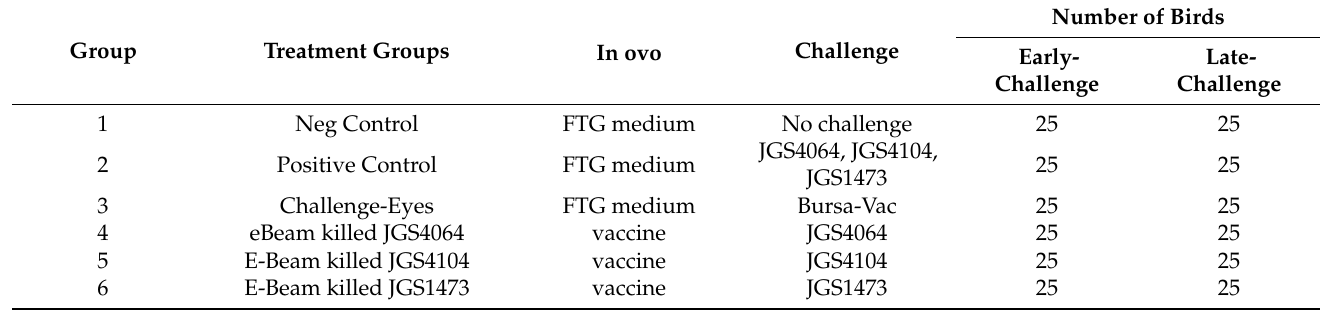
Table 1. Experimental design. FTG, fluid thioglycolate